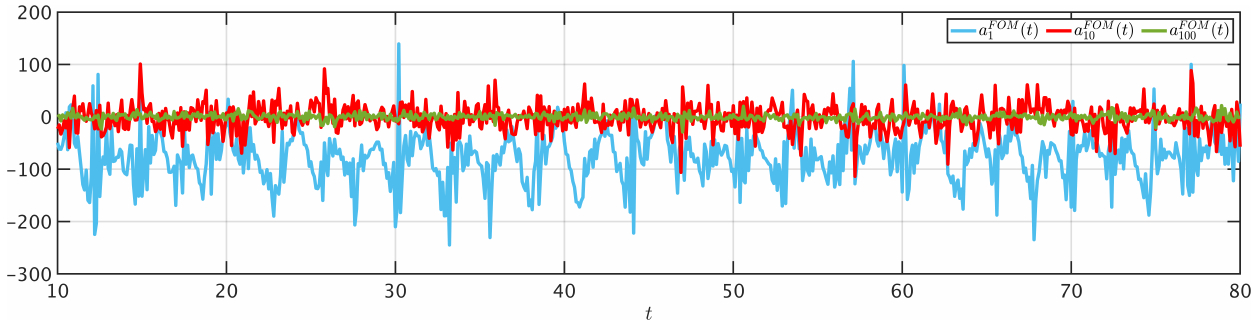
Figure 7. Time evolution of a FOM